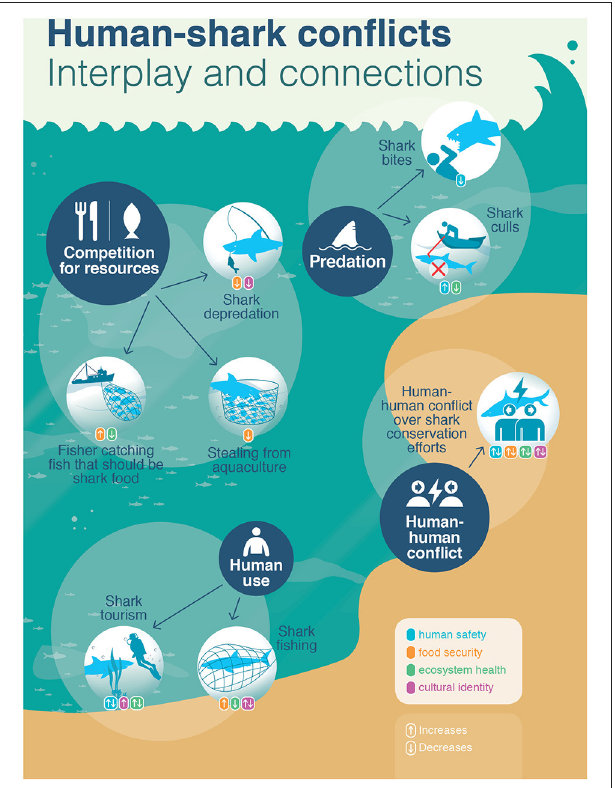
FIGURE 1 | Shark-human conflict is a multidimensional problem that is limiting the implementation of successful conservation action for sharks, and also leads to human-human